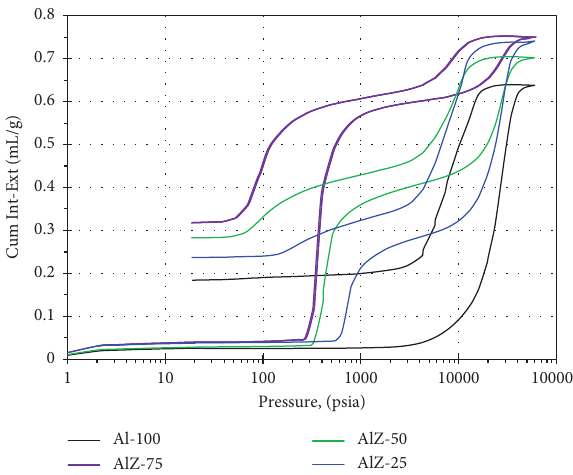
Figure 5: Variation of pore size distribution as a function pore